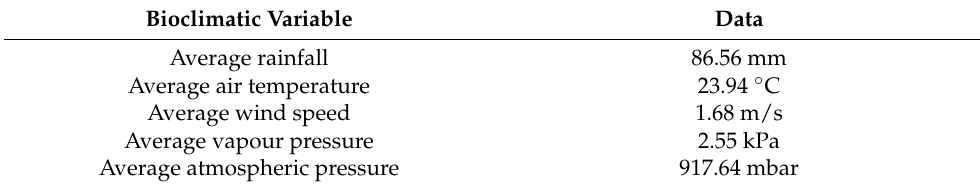
Figure 1. ( a ) Location of the study area and ( b ) maize crop field in Swayimane, South Africa. Table 1. Bioclimatic conditions of Swayimane during the maize growing season.